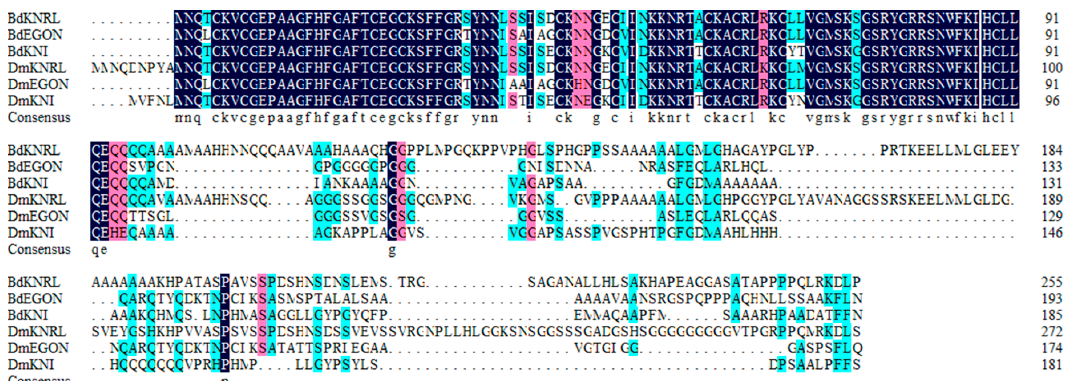
Insects 2019 , 10 , x FOR PEER REVIEW 9 of 16 independent biological replicates and two technical replicates were performed for each qRT-PCR. Larval midgut (L MG); larval fat body (L FB); larval cuticle (L BP); larval Malpighian tubule (L MT); larval central nervous system (L CNS). Warm colors (i.e., red) indicate high expression levels and cold colors (i.e., blue) indicate low expression levels. 3.4. Multisequence Alignment Conserved regions in the NR0, NR1 and NR2 subfamily of B. dorsalis and D. melanogaster NR proteins were presented in Figures 6–8. The B. dorsalis genome contained three members of the NR0 subfamily. The BdKNRL , BdKNI , and BdEGON receptors were similar to the D. melanogaster Knirp receptors DmKNRL , DmKNI , and DmEGON and shared a high identity at their 5' ends (Figure 6), whereas there was very little similarity at their 3' ends. The B. dorsalis genome contained five members of the NR1 subfamily. These BdNRs were similar to DmNRs (Table 1, Figure 1). They phylogenetically segregated into the NR1 clade and displayed few similarities to other NR groups